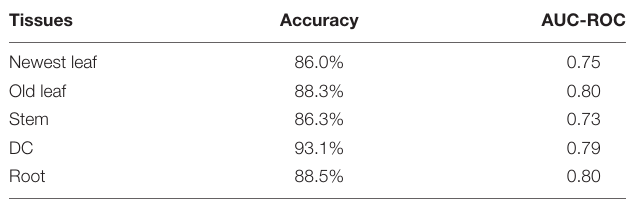
TABLE 2 | Accuracy of the Fe excess response simulation model in each